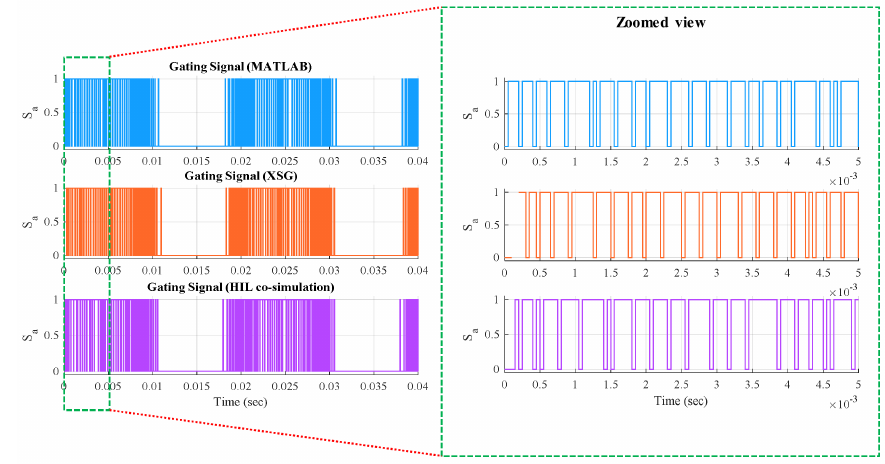
Figure 12. Switching signal for the first leg upper switch ( S a ) obtained using MATLAB/Simulink, XSG, and HIL co-simulation.